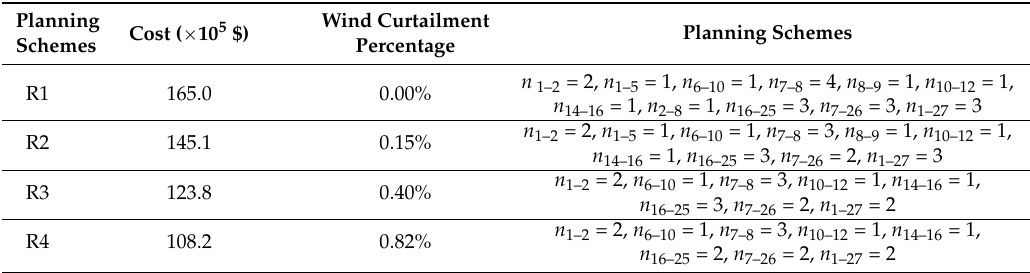
Table 1. Four planning schemes for IEEE RTS-24 system.